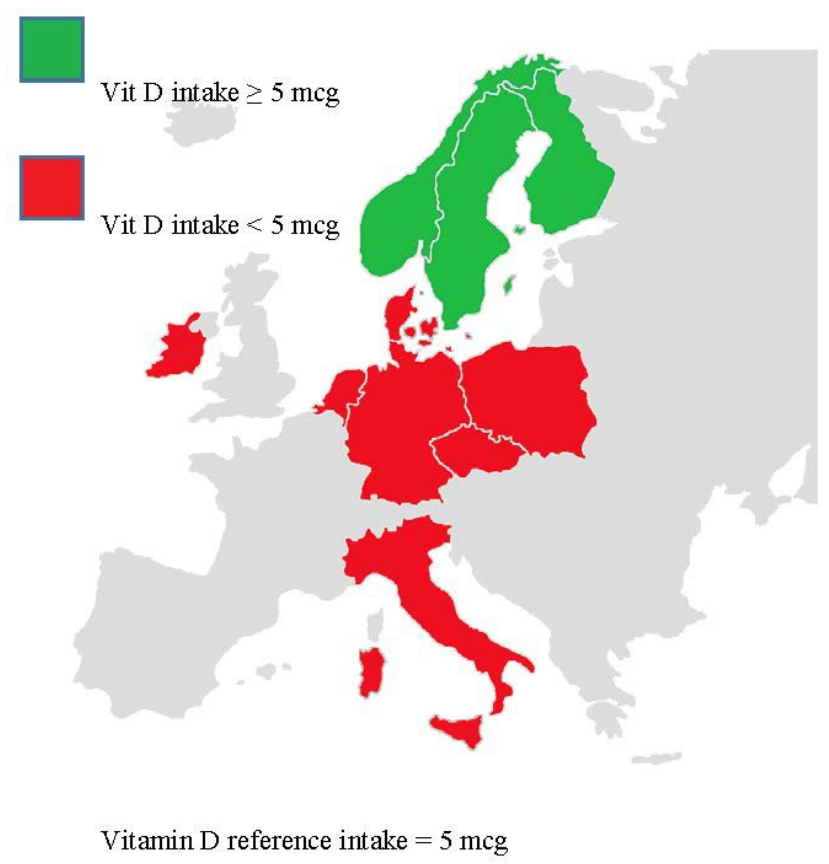
Figure 2. Vitamin D intake in European children aged 4–18 years